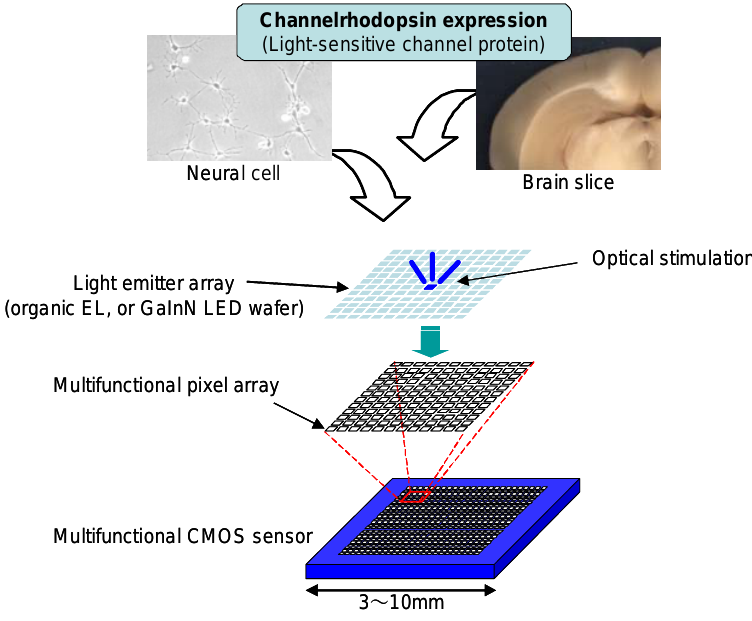
Figure 13. Concept of the multifunctional biointerface (neural-interface)